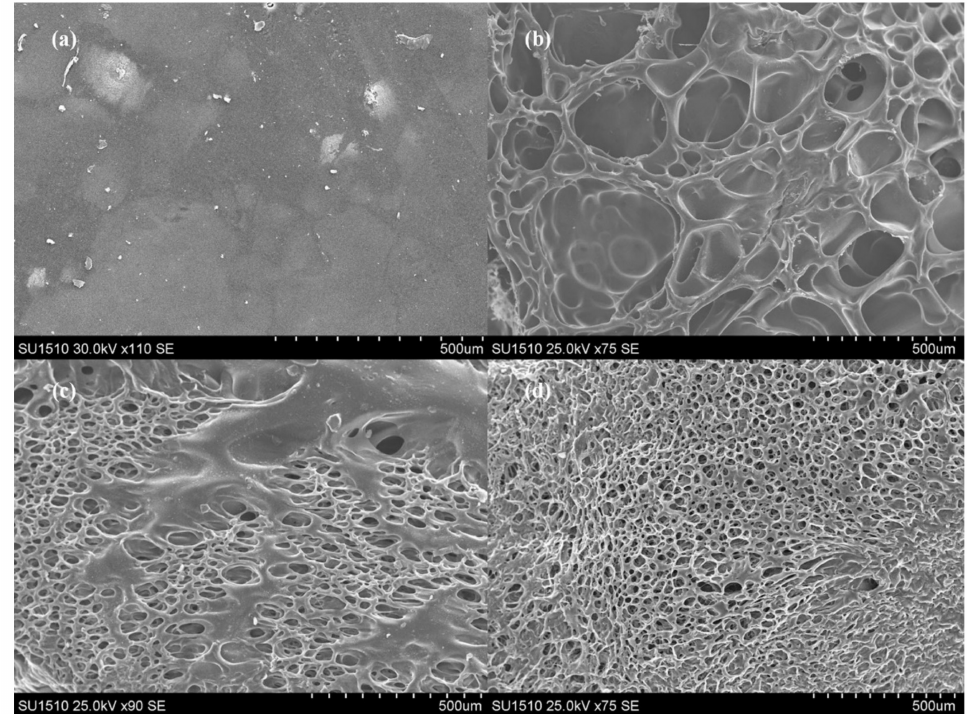
Figure 9. Surface micrographs of G4 sample: ( a ) initial, ( b ) after 9 days, ( c ) after 89 days, and ( d ) after 193 days of